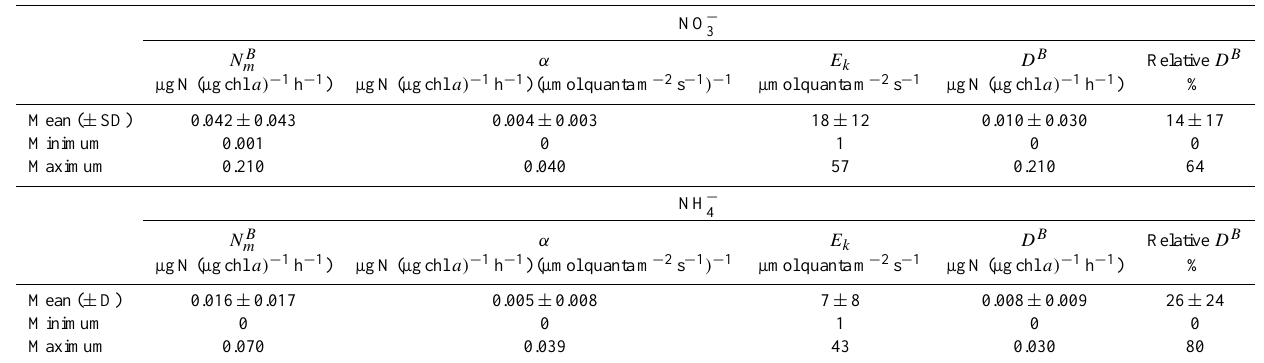
Table B1. Summary of uptake-irradiance parameters for N uptake (trace 15 N additions) at the